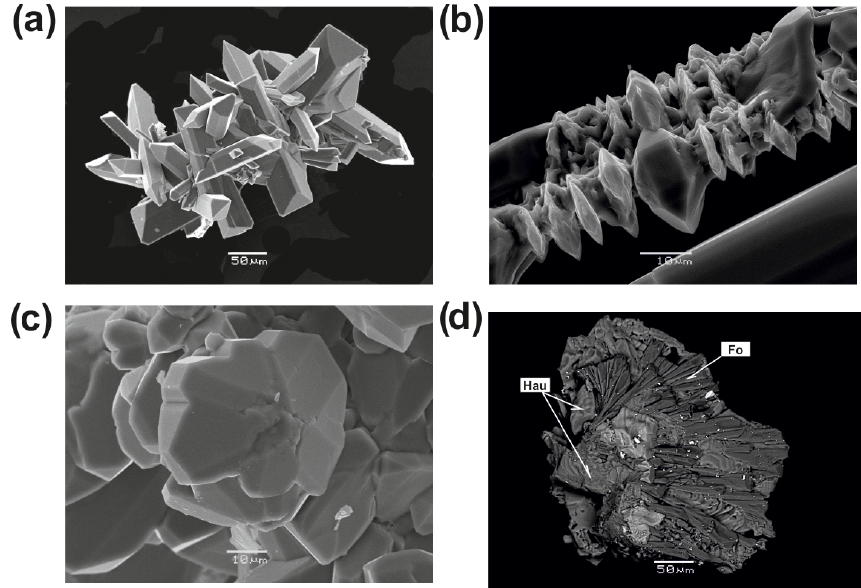
Figure 2. Morphology of forsterite from the Arsenatnaya fumarole: (a) aggregate of well-shaped prismatic crystals, (b) lens-shaped crystals overgrowing acicular crystals of anhydrite, (c) trilling on (110), (d) fragment of aggregate of forsterite “cemented” by hauyne. Secondary electron (SE) images.